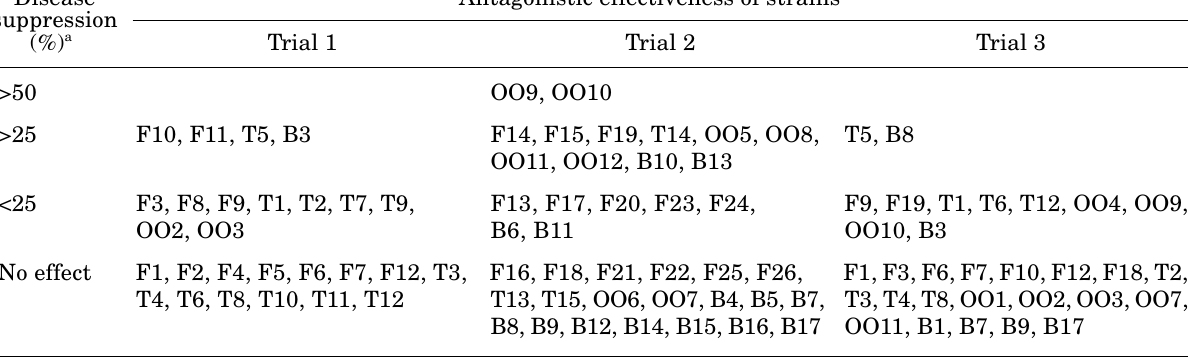
Table 3. Reduction of P. cryptogea root rot of gerbera achieved by selected strains of Fusarium , Trichoderma , oomyc- etes and bacteria applied by soil mixing (fungi) or root dipping (bacteria) in open soilless systems (first and second trial, Albenga, 2000; third trial, Albenga,